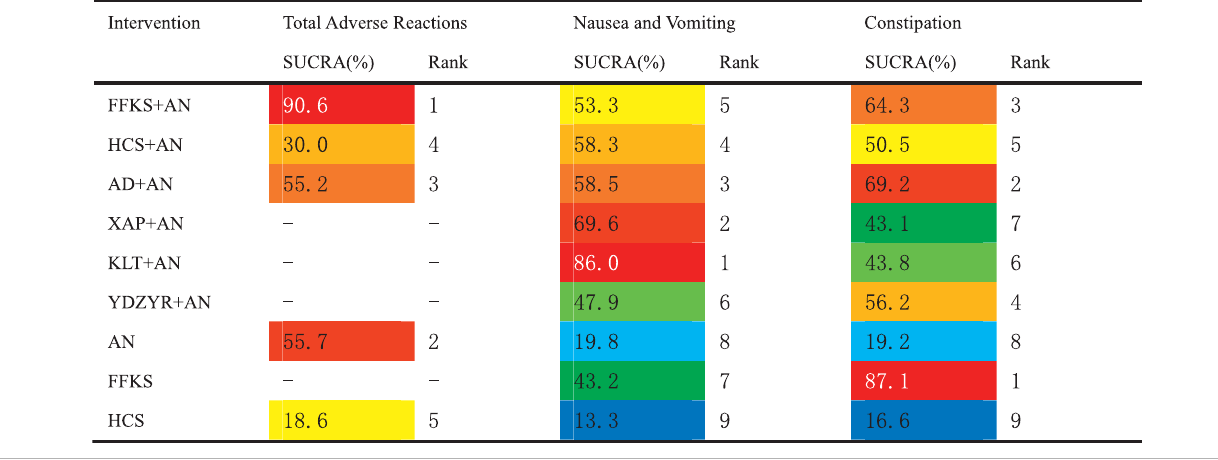
Note: The warmer the color, the greater the SUCRA, and the greater the probability of becoming the best intervention. FFKS + AN, Fufangkusheninjection + analgesic;HCS + AN, Huachansu injection+ analgesic; AD + AN, Aidi injection + analgesic;XAP + AN, Xiaoaipinginjection + analgesic;KLT + AN,